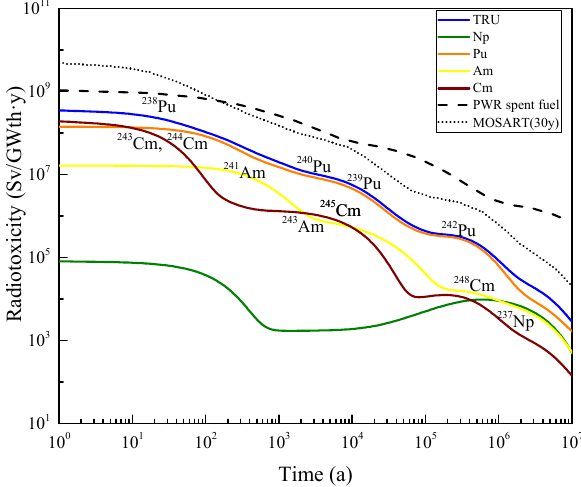
Figure 12. Radiotoxicity of discharged MCSFR TRU wastes. The radiotoxicity of FPs during online reprocessing has a non-negligible impact on the final repository. A loss rate of 10 − 5 for TRU elements and 10 − 7 for uranium isotopes is assumed during reprocessing. Figure 13 shows the evolution of radiotoxicity of nuclear waste. The radiotoxicity drops to the radioactivity level of natural uranium ore within 300 years.